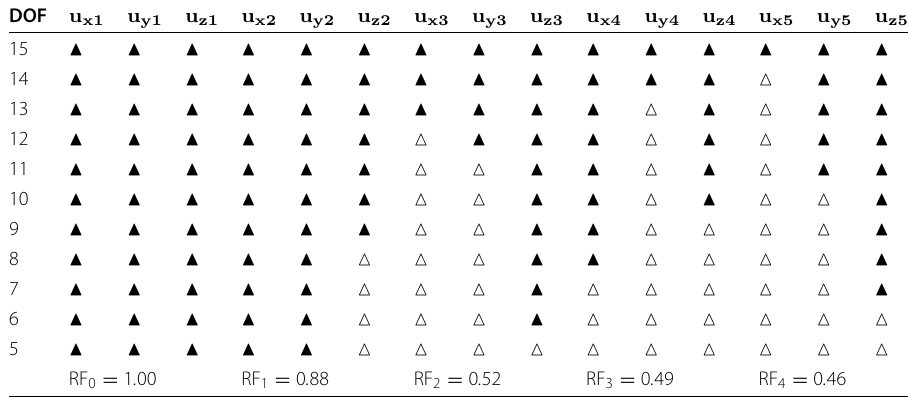
Table 12 BTD models, 0/90/0/90, a/h =